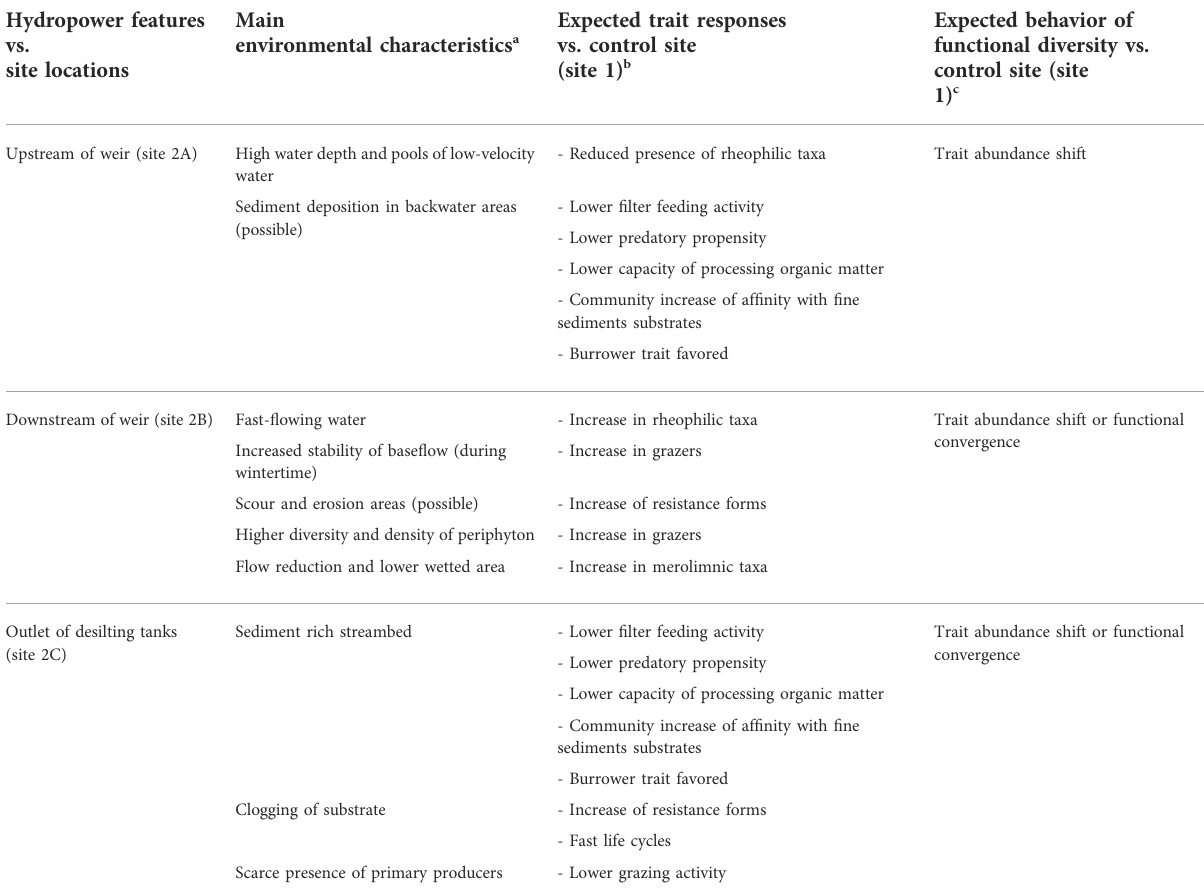
TABLE 1 Detailed set of a priori hypotheses relating sampling sites, main anticipated environmental characteristics, trait responses, and behavior of functional diversity. Site 1 is not reported, since it is the unimpacted control site. Hydropower features